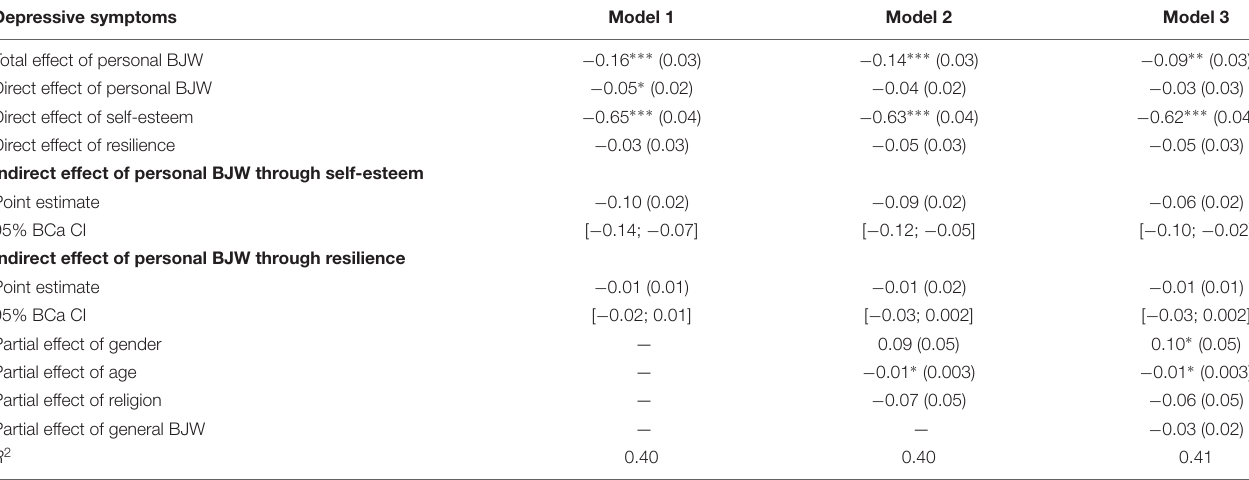
TABLE 2 | Results from bootstrap mediation analyses for depressive symptoms ( N = 627).